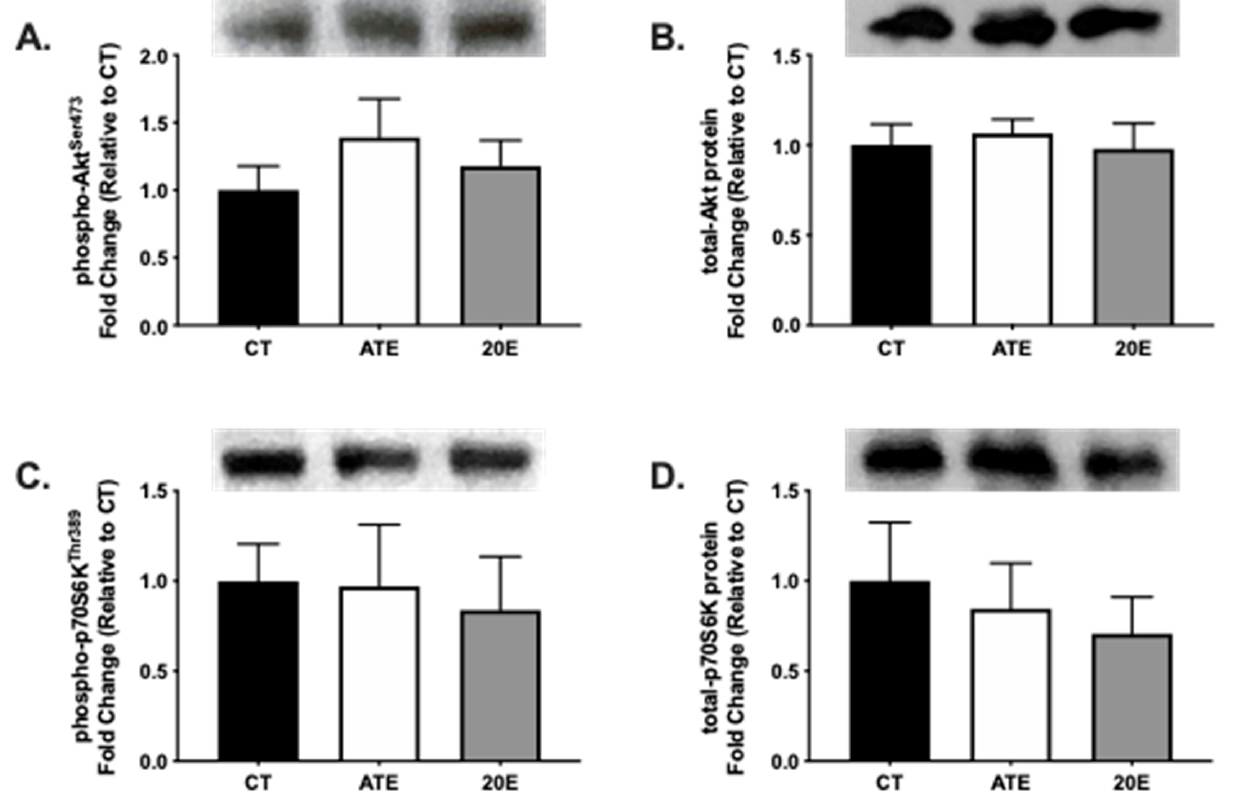
Figure 2. Protein analysis of markers of protein synthesis signaling in aging gastrocnemius muscle via Western blot after the 28-day supplementation period. Quantification of phosphorylated Akt ( A ), total Akt protein ( B ), phosphorylated p70S6K ( C ), and total p70S6K protein ( D ) by treatment, respectively. Representative Western blot protein bands are provided. Data are normalized to CT and presented as mean ± SEM. CT, control; ATE, A. turkestanica extract; 20E, 20-hydroxyecdysone. No significant differences were found, p > 0.05, all.